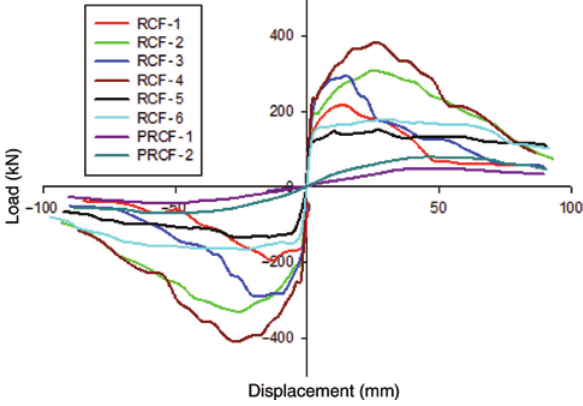
Figure 8: Load-displacement envelope curves of test frames.